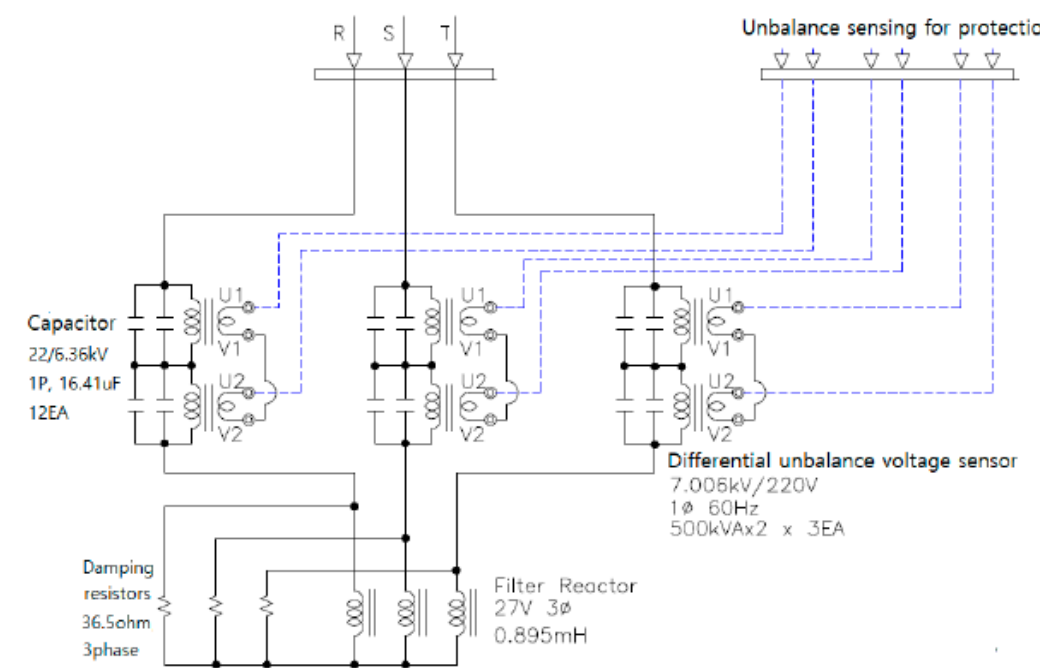
Figure 5. Single line drawing of passive filter [18].